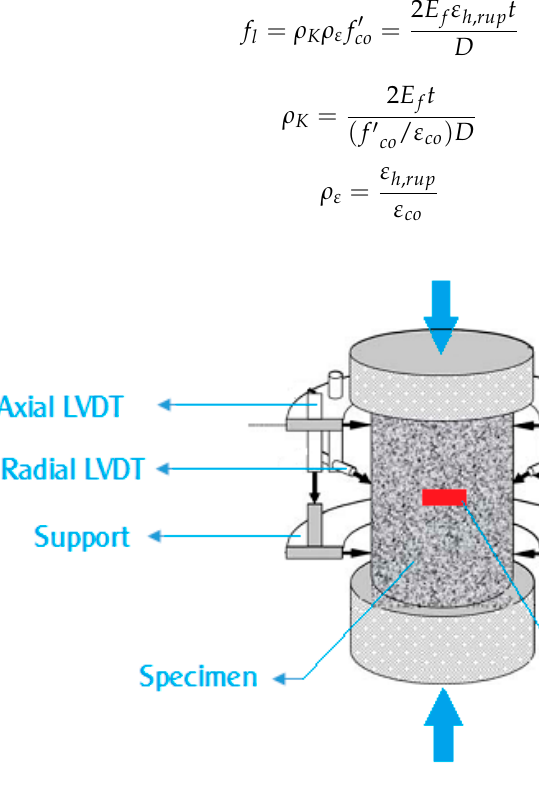
Figure 3. Test setup and instrumentation [50]. Table 1. Statistics for the experimental data.